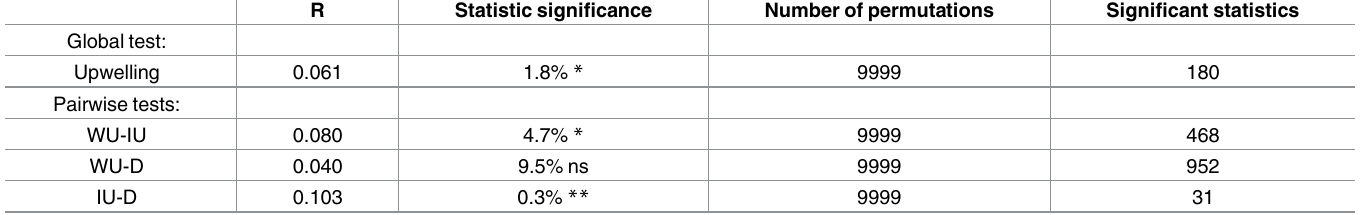
Table 2. Results of the one-way ANOSIM (global and pairwise tests)for the MDS performed with all samplescollected. Differencesbetweensamples collectedduringperiods of intenseupwelling(IU), weak upwelling(WU) and downwelling(D) were assessed. The statistic estimated for each permutation is significantwhen its value is greater than or equal to the sample statistic. Significancelevel is calculatedas the percentage of significantstatistics in the total number of permutationsused. R: Sample statistic.